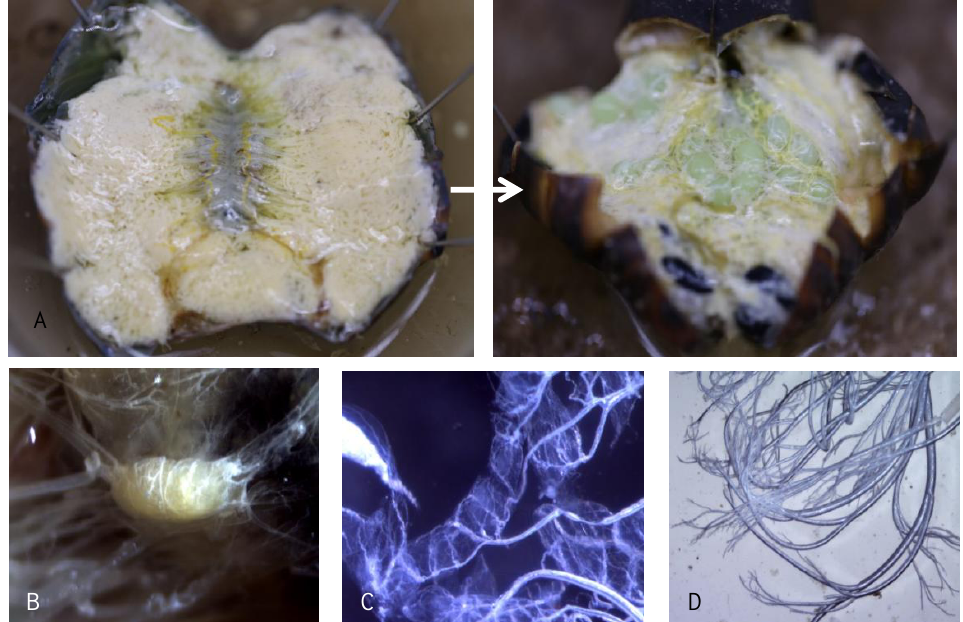
Figure 2. Morphological changes in the pupae: ( A ) Changes in the bodies of pupae, with respect to fat body, gut, and eggs (female). Before development, the whole body is full of fat, but after development, eggs emerge, and fat bodies reduce considerably. ( B ) Pupal brain. ( C ) Pupal prothoracic gland. ( D ) Pupal tracheae.